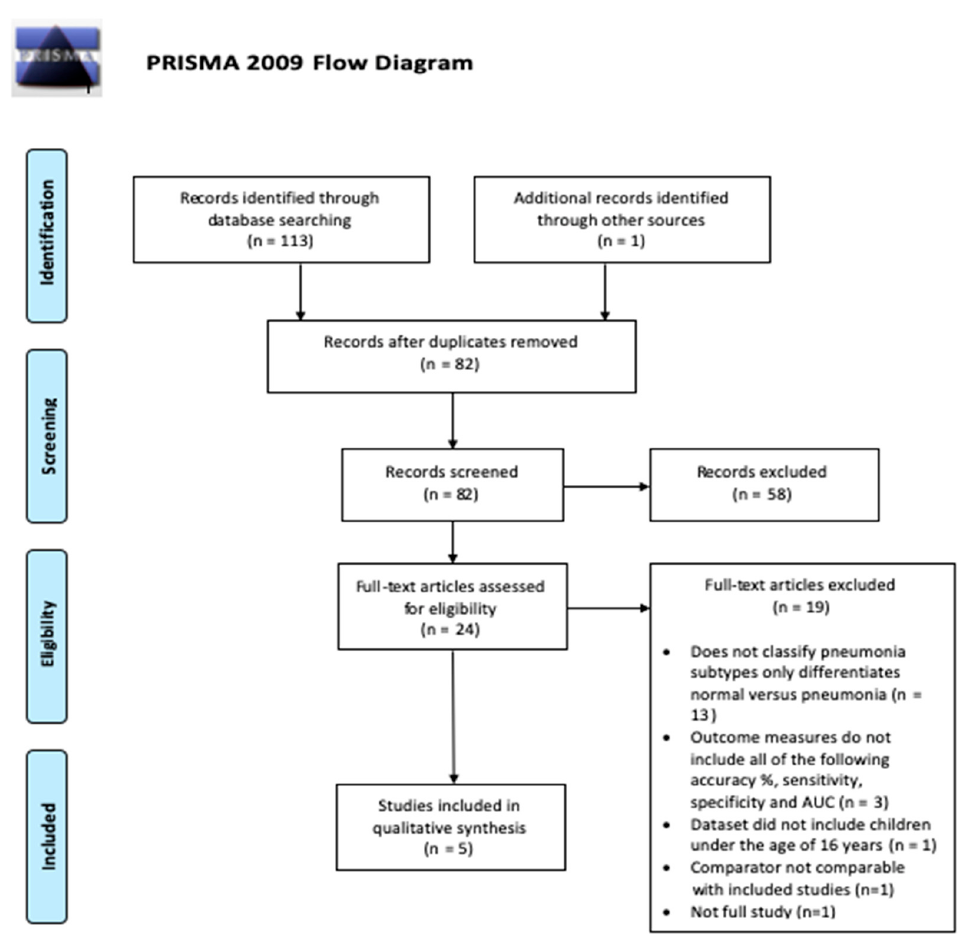
Figure 1. A PRISMA flow chart illustrating the filtering and gathering of eligible studies.